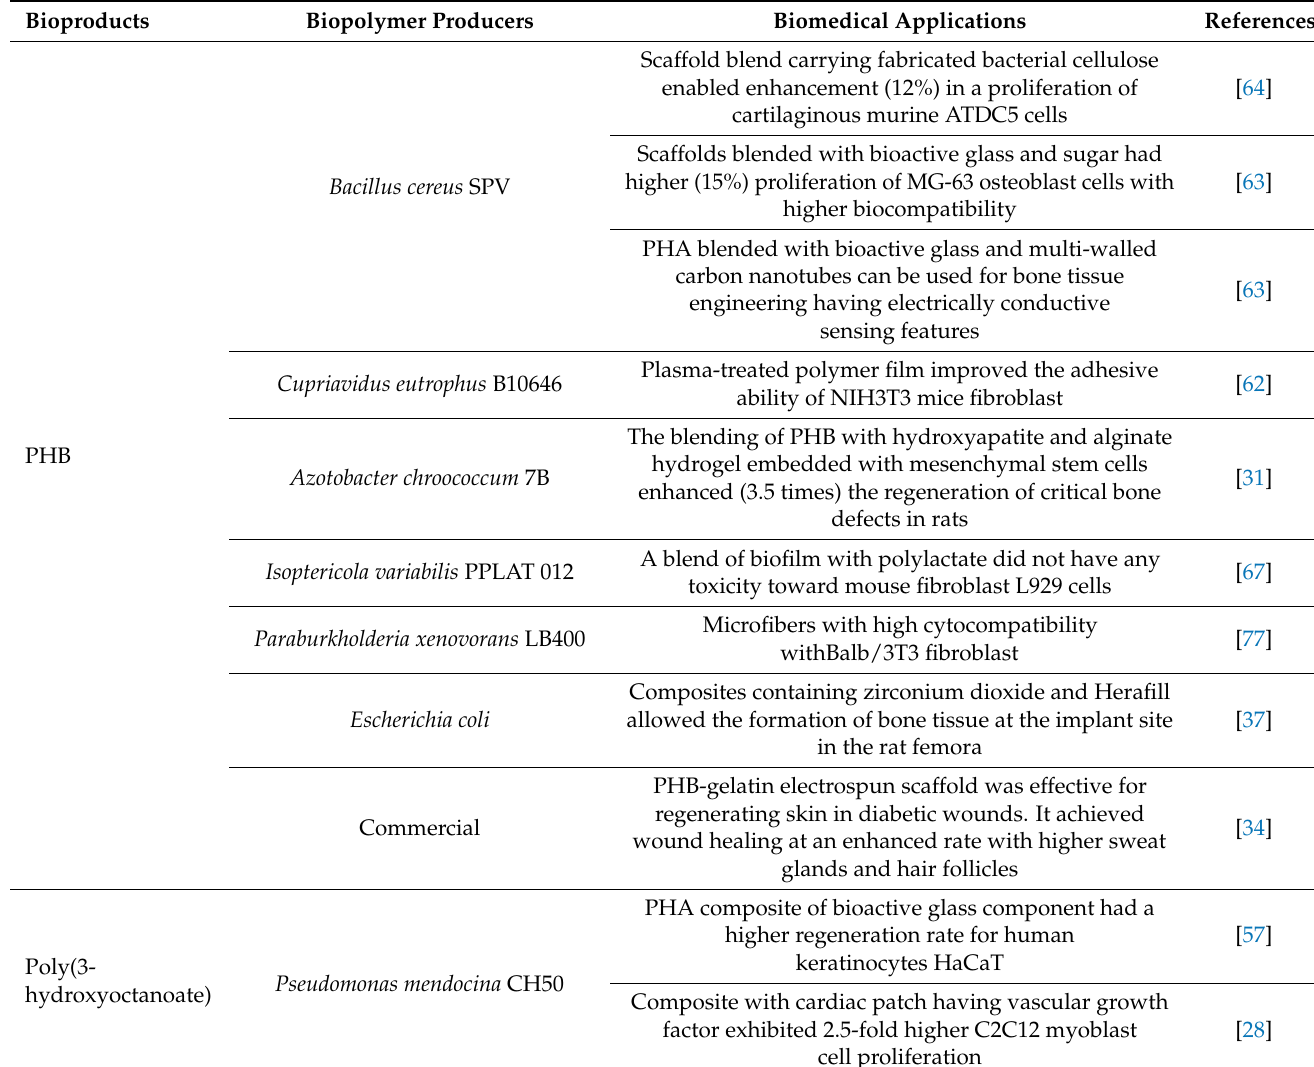
Table 1. Diversity of biomedical applications of polyhydroxyalkanoates and their derivatives in tissue